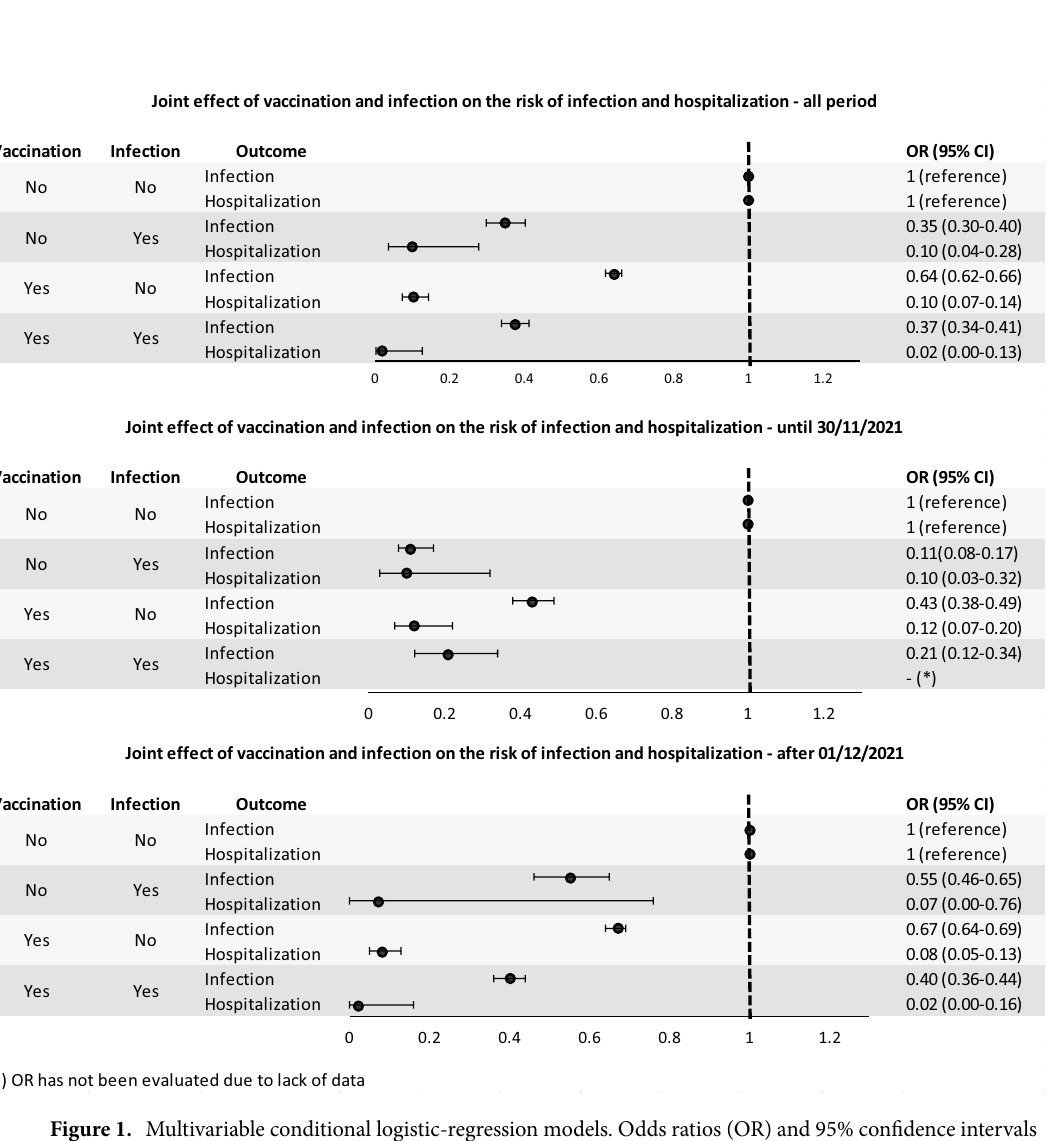
Figure 1. Multivariable conditional logistic-regression models. Odds ratios (OR) and 95% confidence intervals (95%CI) for the association between joint effect of vaccination and previous infection and risk of new infection and hospitalization. Results are stratified by wave of infection and adjusted by vulnerability index (Datas on Table